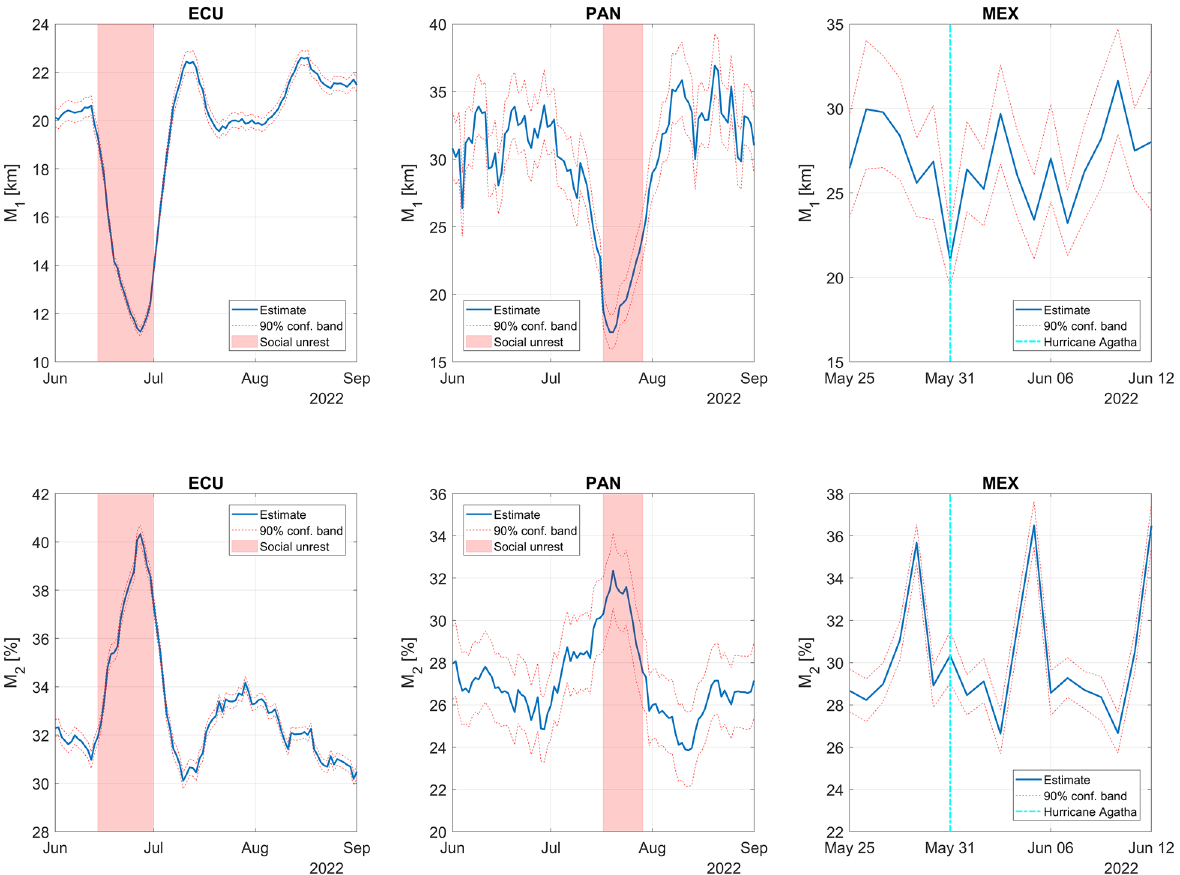
Figure 2. Variations in mobility metrics M 1 and M 2 during 2022 social unrest in ECU and PAN and when Hurricane Agatha struck Oaxaca, MEX. For ECU and PAN, mobility metrics are based on 7-day smoothing. For MEX, no smoothing is